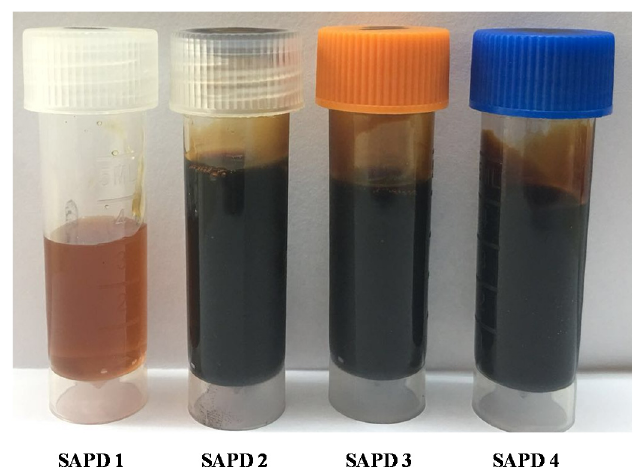
Figure 2. Appearance of synthesized SADP adhesives.